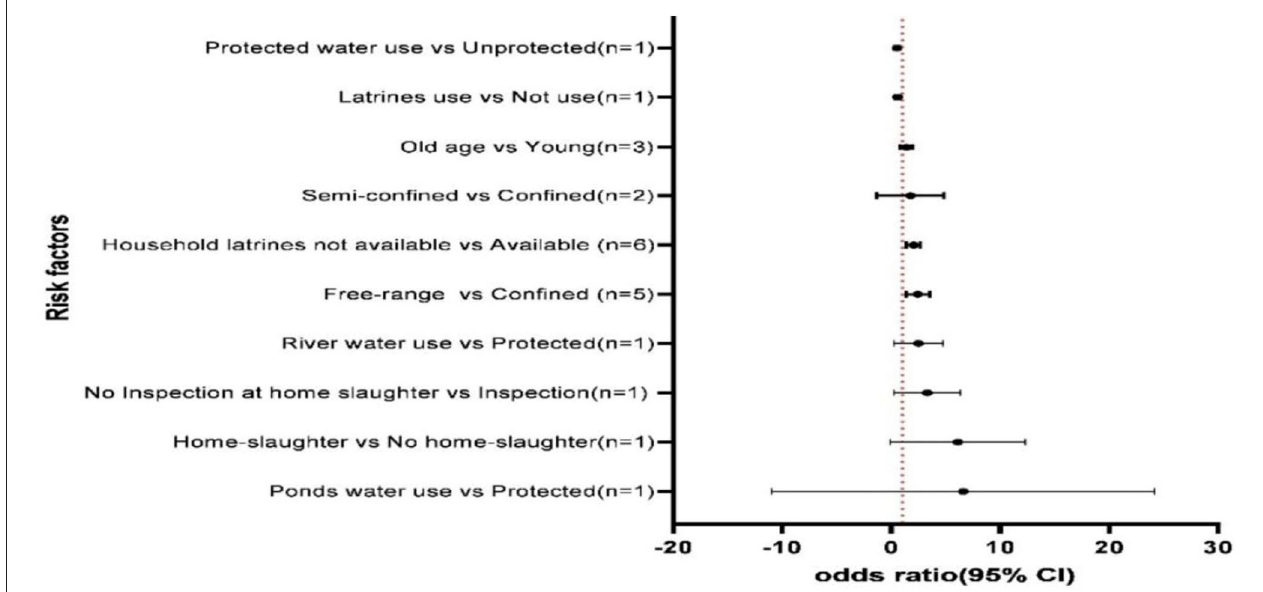
FIGURE 7 | Overview of the meta-analyses results of pooled odds ratio (OR) for significant risk factors of porcine cysticercosis in ESA (n, number of studies that are included in the analysis).